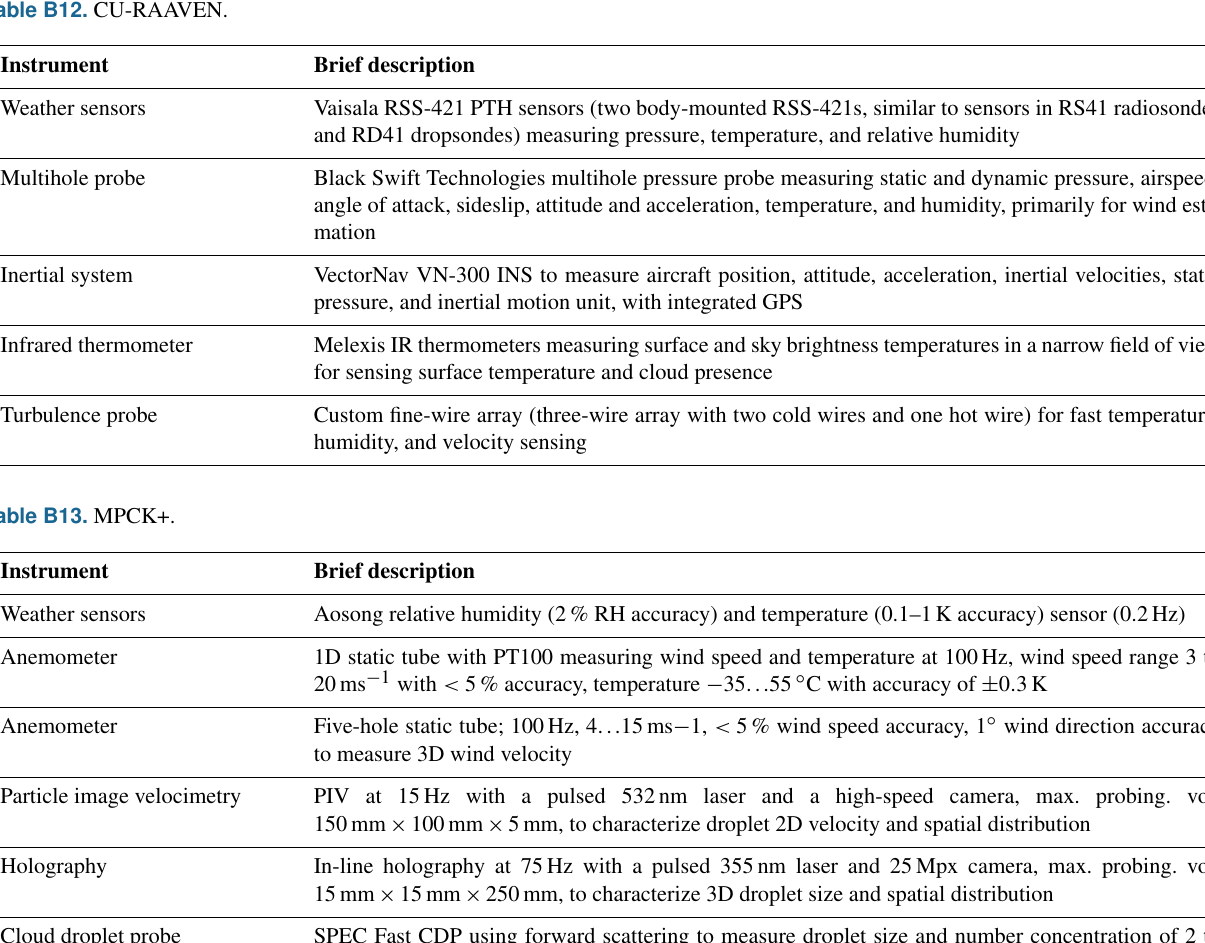
Table B12. CU-RAAVEN.